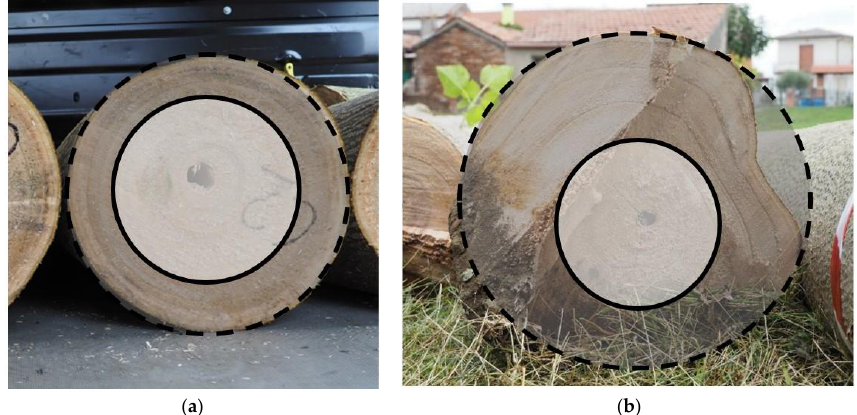
Figure 6. Thickness of the first two annual rings (white area delimited by the black continuous line) and of the subsequent four annual rings (light grey area delimited by the dashed line) observed in one interior tree ( a ) and in one tree grown at the edge ( b ) of plantation C.